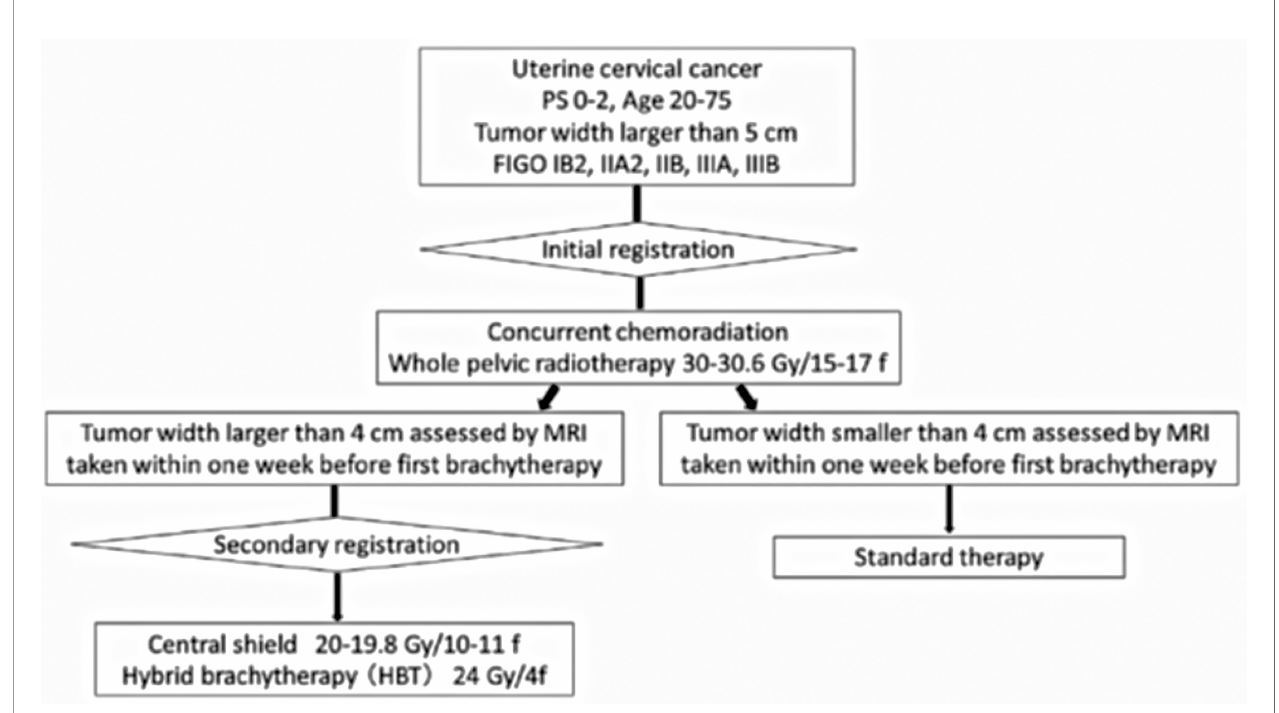
FIGURE 4 | Shema of the phase I/II trial of hybrid brachytherapy.